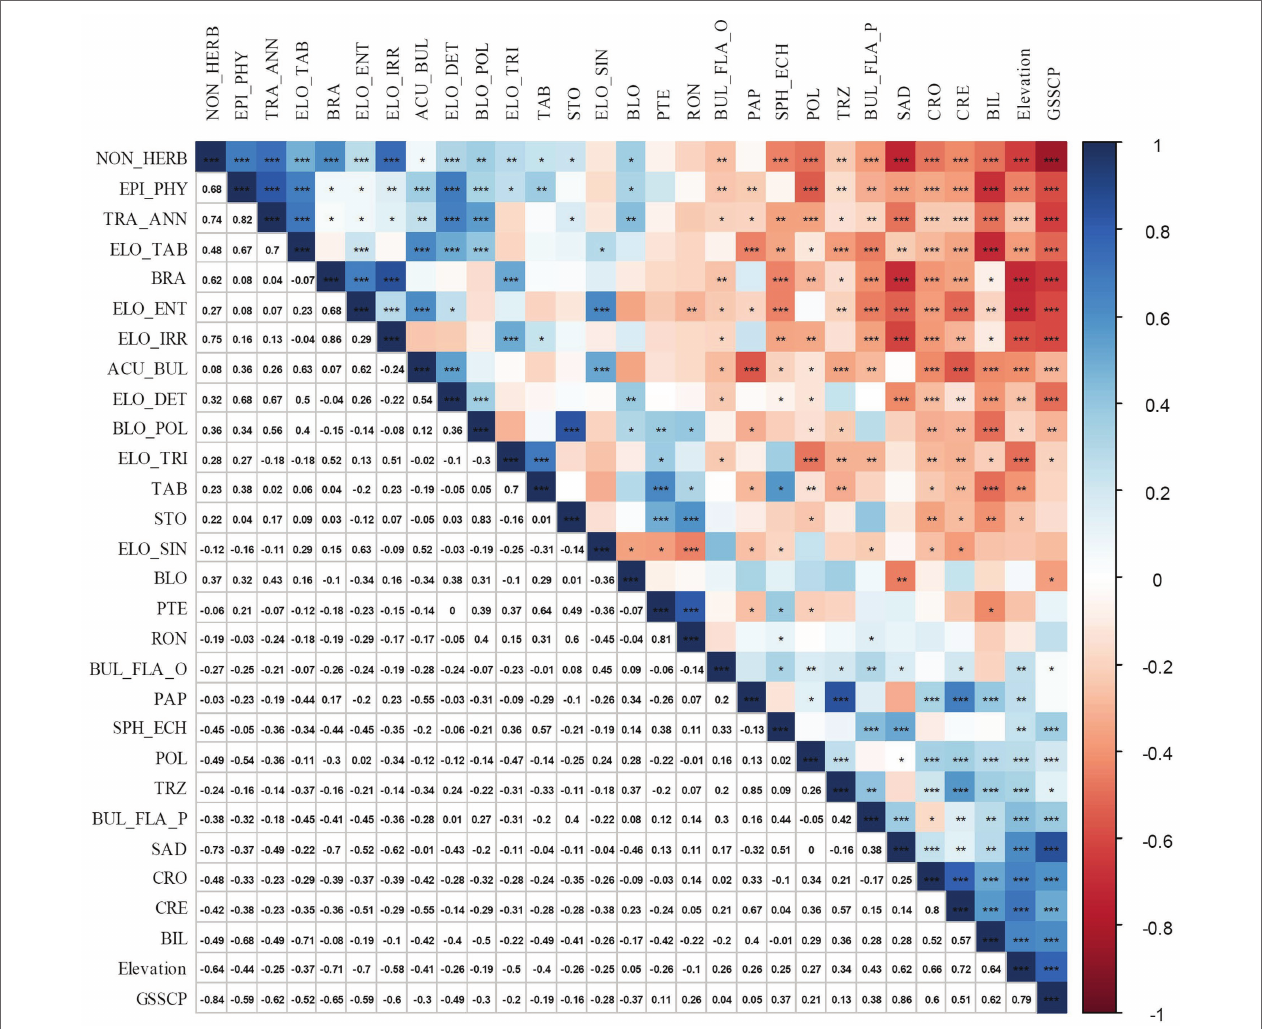
FIGURE 4 | Correlation matrix made using the R package “corrplot,” between phytolith morphotype’s percentage and environmental parameters for the topsoil plots collected in the Daiyun Mountains. The legend on the right side of the diagram shows the Pearson correlation coefficients with their corresponding colors. Positive correlations are displayed in blue and negative correlations in red. *, **, and ***denote the statistical significance at α = 0.05, α = 0.01, and α = 0.001, respectively. Phytolith codes (abbreviations) used here are referred to International Committee for Phytolith Taxonomy (ICPT) (2019). Particularly, EPI_PHY denotes E pidermal phytolith ; ELO_IRR denotes E longate irregular ; ELO_TAB denotes E longate tabular ; BRA denotes B rachiate ; PTE denotes P teridophyte -type; BUL_FLA_P denotes B ulliform flabellate that is produced by Phragmites ; BUL_FLA_O denotes general B ulliform flabellate ; TAB denotes T abular ; STO denotes silicified S toma